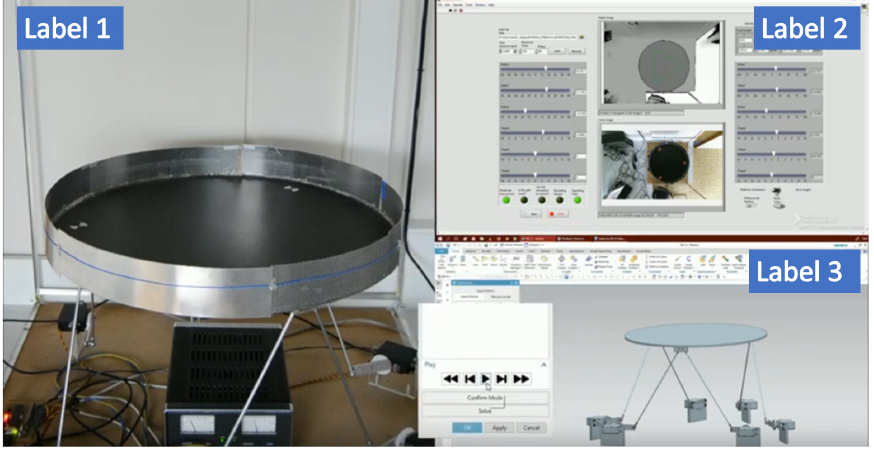
Figure 8. Example of co-simulation interface and real-time tracking between the 6DOF platform and virtual